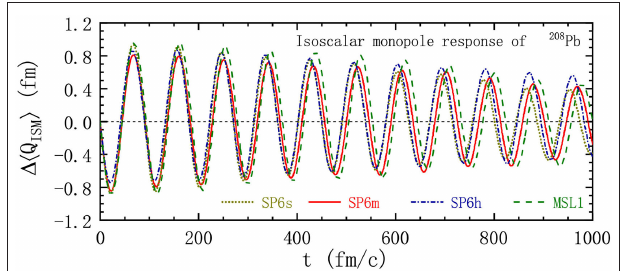
FIGURE 4 | Time evolution of 1 hˆ Q ISM of 208 Pb after a perturbation by i 1 / c in the LHV calculations. The ˆ H ex ( t ) = λ ˆ Q ISM δ ( t − t 0 ) with λ = 100 MeV · fm − results correspond to three N3LO Skyrme pseudopotentials, SP6s, SP6m, and SP6h, and one conventional Skyrme interaction MSL1. Reproduced from reference [61] with permission from the American Physical